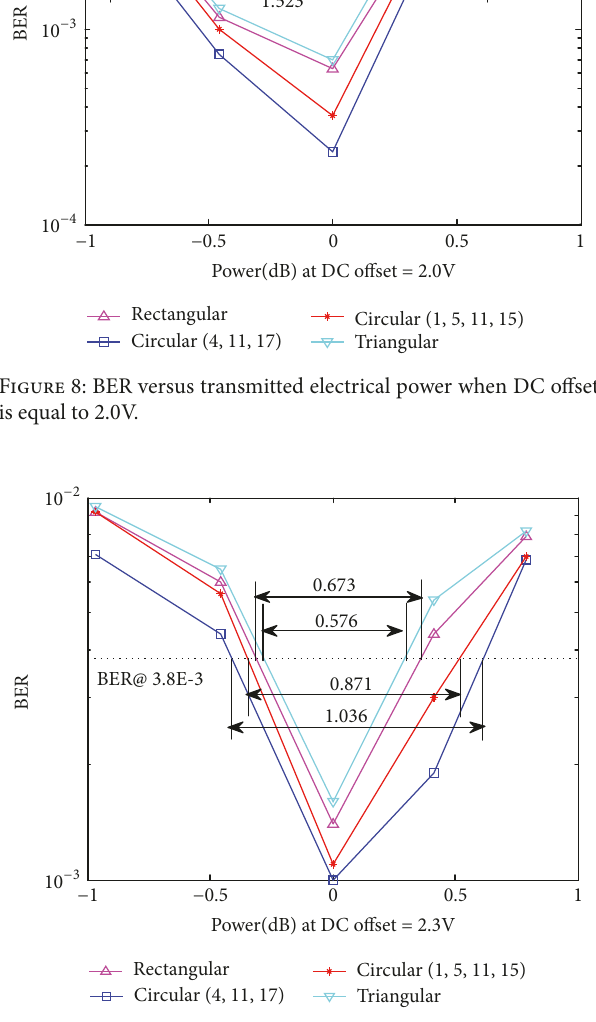
Figure 9: BER versus transmitted electrical power when DC offset is equal to